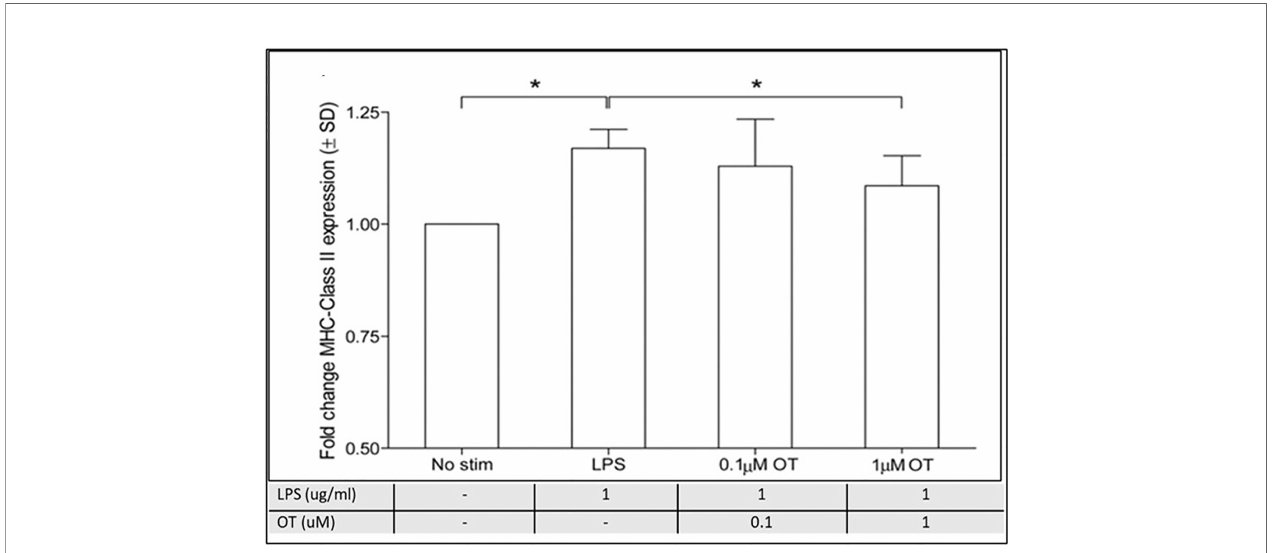
FIGURE 8 | Oxytocin suppresses microglial reactivity in vitro . A) MHC class II expression is up-regulated following a 24-hour LPS challenge (1 m g/mL) in microglial cells. Preincubation with the high dose (1 m mol/L), but not the low dose (0.1 m mol/L), OT dose-dependently attenuates LPS-stimulated MHC class II expression. However, this effect is blocked by coincubation with oxytocin receptor antagonist (1 m mol/L), n=7 per treatment condition, data are expressed as mean ± SD. *Indicates a statistically signi fi cant difference between indicated groups, (P>0.05) (90, 97). Figure from Open access AHA journals (97) permissible to re-use under a CC-BY 4.0